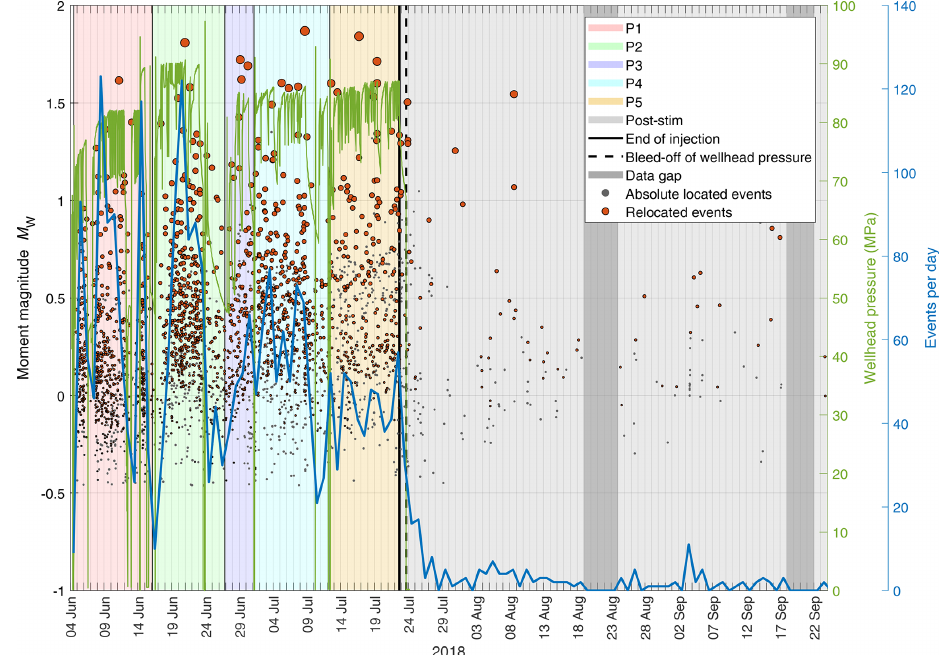
Figure 2. Stimulation protocol with moment magnitudes of induced seismicity during stimulation phases P 1– P 5 and post-stimulation time period. The magnitudes of 2958 absolute located and 1986 relocated events are shown as grey and orange dots, respectively. The solid green line represents the wellhead pressure during the stimulation. The seismic event rate per day is shown by the solid blue